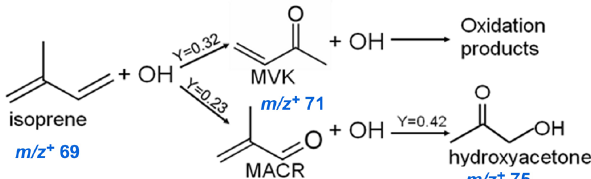
Fig. 6. Basic schematic of isoprene photooxidation with branching ratios (adapted from Karl et al.,